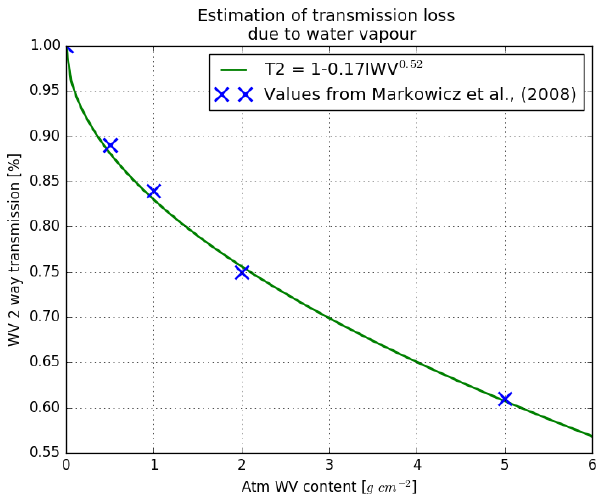
Figure 4. Estimated transmission loss due to the atmospheric wa- ter vapour content. The blue crosses are the values calculated by Markowicz et al. (2008) for a ceilometer with a wavelength of